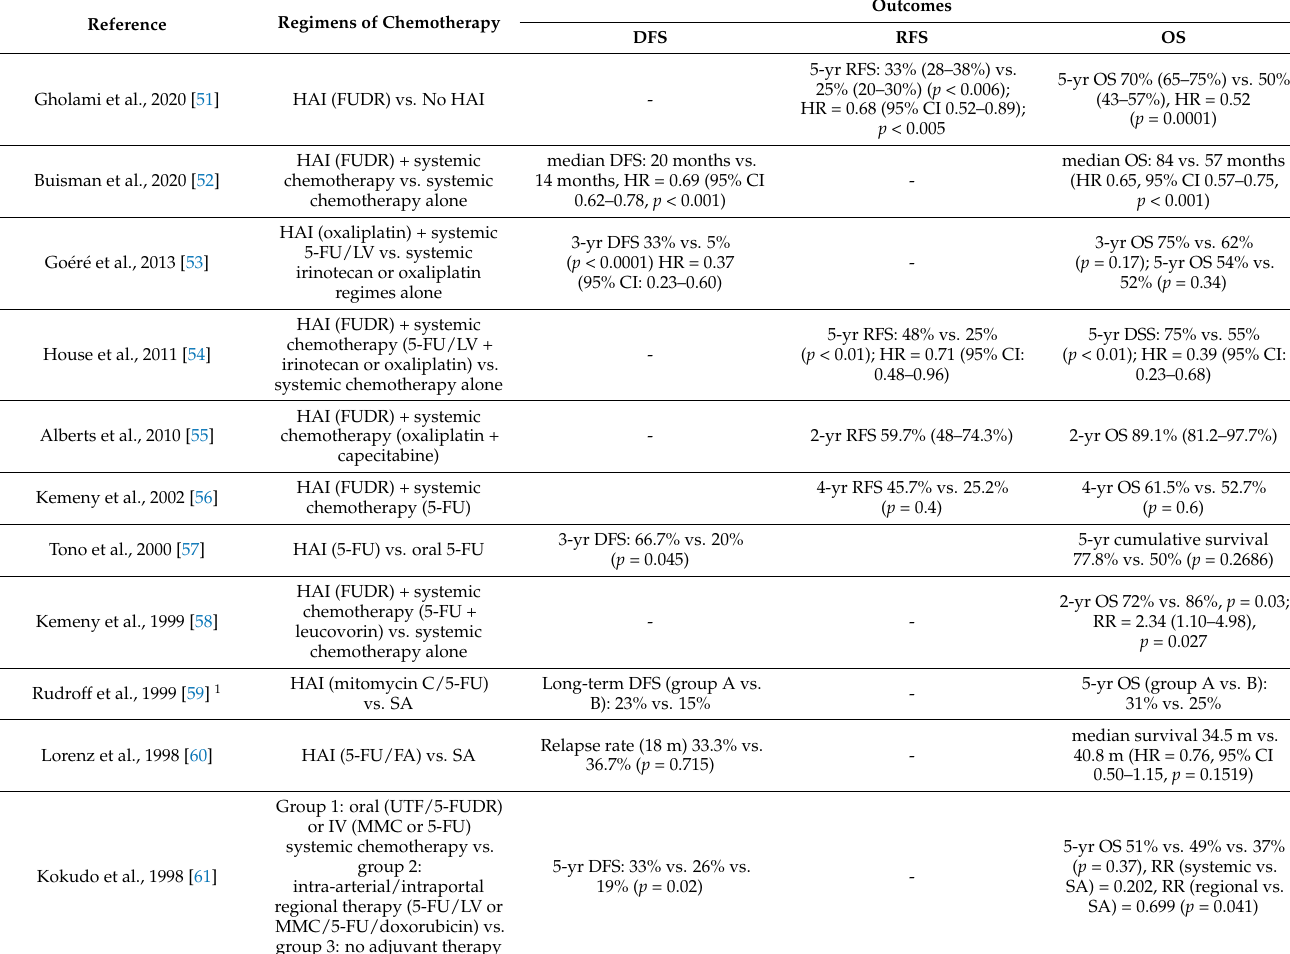
Table 4. Outcomes of studies investigating adjuvant HAI